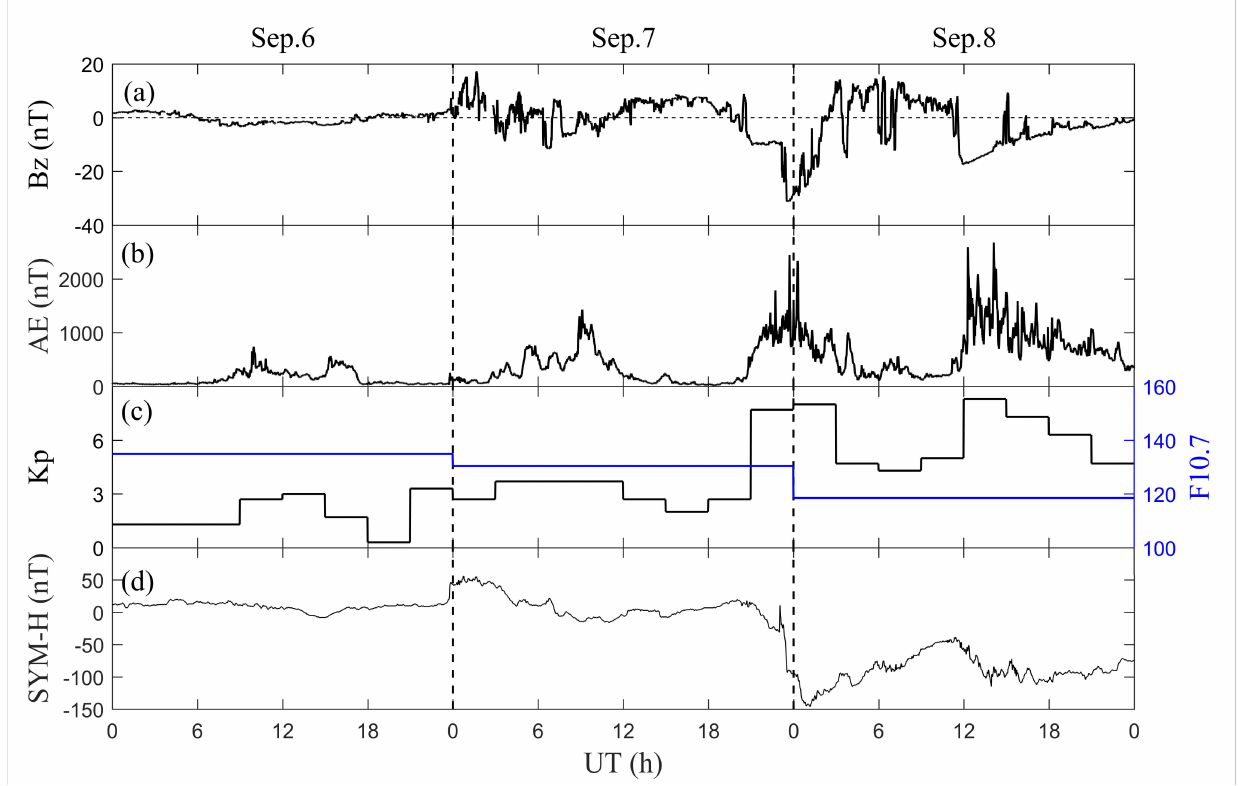
Figure 4. Time series of ( a ) IMF Bz, ( b ) AE index, ( c ) Kp index (dark line) and F10.7 (blue line), and ( d ) SYM-H index during the period of 6 − 8 September